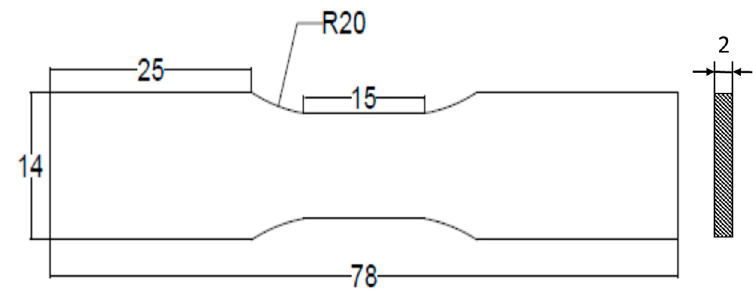
Figure 3. Sample geometry for low cycle fatigue testing (dimensions are given in mm).